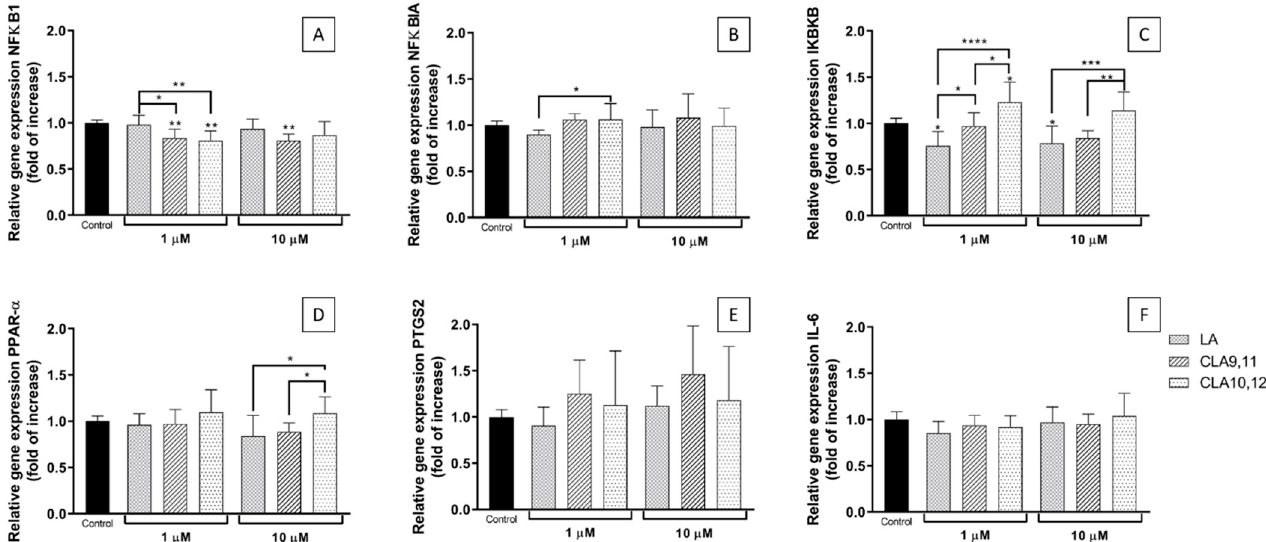
Figure 4. Expression of NF κ B1 ( A ), NF κ BIA (for I κ B α , ( B )), I κ BKB (for I κ K- β , ( C )), PPAR- α ( D ), PTGS2 (for COX-2, ( E )), and IL-6 ( F ) genes in EA.hy926 cells preincubated for 48 h with 1–10 µ M of fatty acid in DMEM containing 0.1% of ethanol (Control) followed by incubation with tumour necrosis factor α (1 ng/mL) for 6 h. Cq values were normalized by the geometric mean of reference targets (RPL13A and CYC1 genes). Bars are mean ± SD of 9 samples from 3 experiments. Data were analysed using one-way ANOVA with Tukey’s post hoc test. * p < 0.05, ** p < 0.01, *** p < 0.001, **** p < 0.0001; where asterisks are shown immediately above a bar they refer to dfference from Control and where asterisks are shown above a horizontal line they refer to differences between the two groups indicated by that line. LA, linoleic acid; CLA9,11, cis -9, trans -11 linoleic acid; CLA10,12, trans -10, cis -12 linoleic acid.